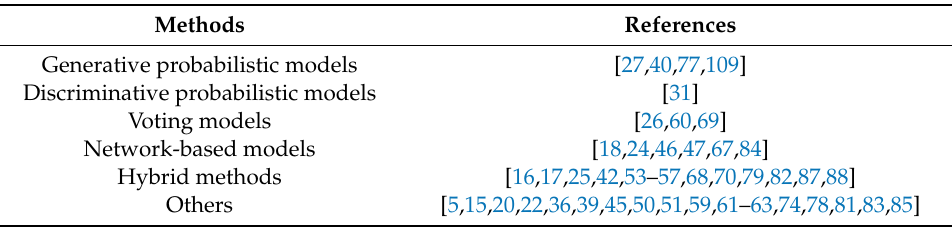
Table 8. Expert finding systems